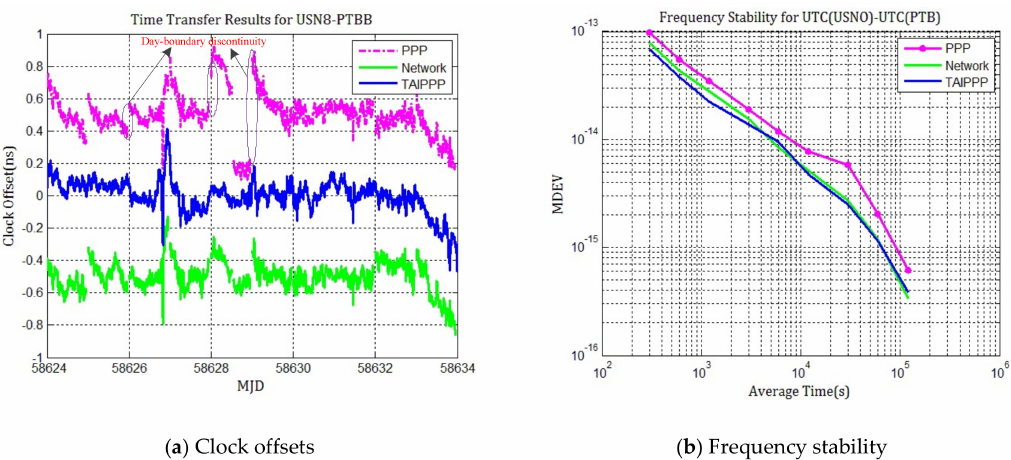
Figure 5. Time transfer and frequency stability results for UTC(USNO)-UTC(PTB). ( a ) Station clock o ff sets for 10 day batches using PPP (purple), network processing (green) and TAIPPP solutions (blue); ( b )Frequency stability for PPP (purple), network processing (green) and TAIPPP solutions (blue).